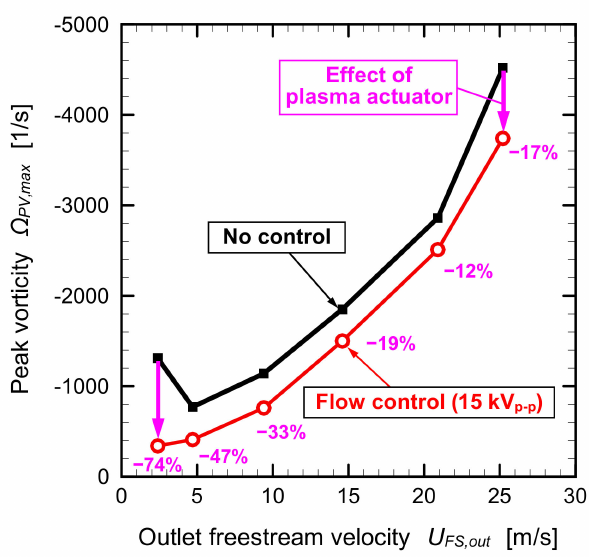
Figure 25. Peak vorticity of passage vortex in center passage at various freestream